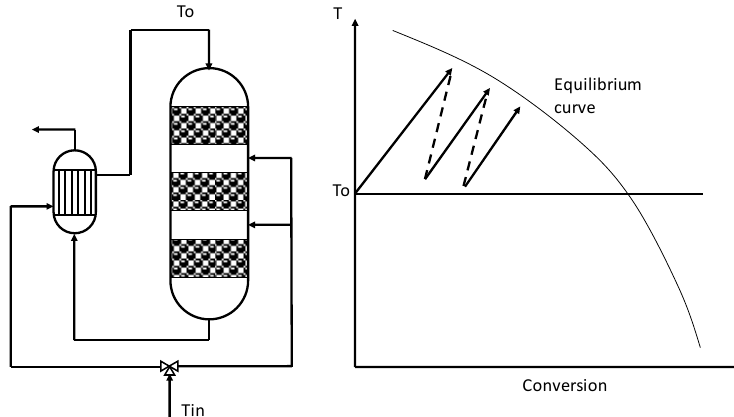
Figure 12. Scheme of a multistage adiabatic reactor (exothermic reaction). ( left ) reactor setup; ( right ) temperature profile.